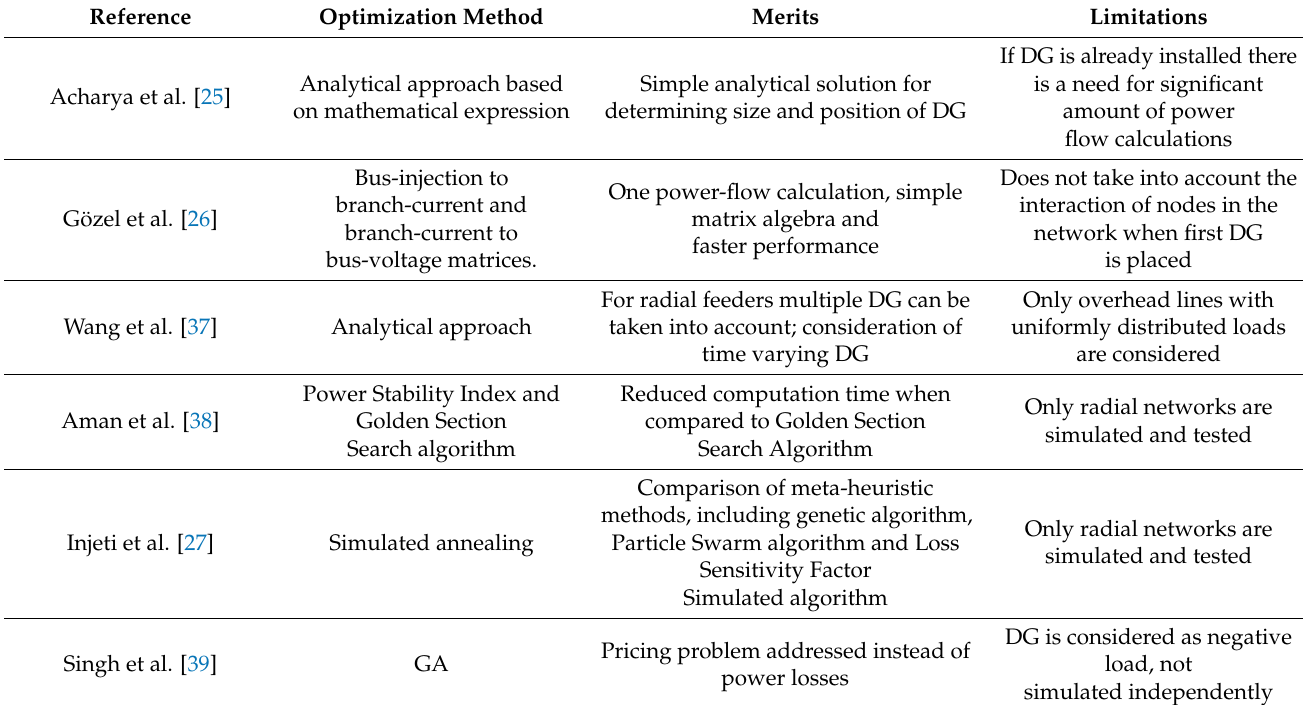
Table 1. Comparison of main content of selected